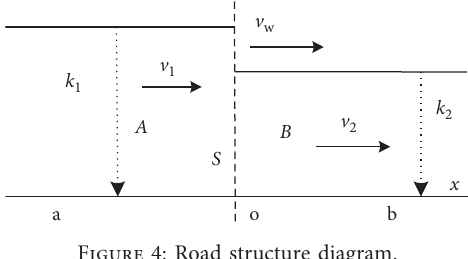
Figure 4: Road structure